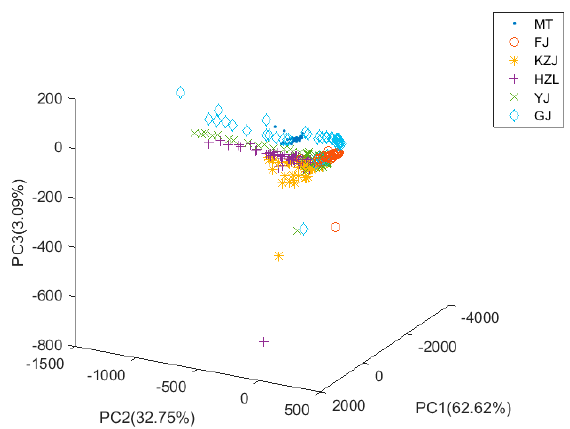
Figure 5. Three-dimensional distribution of data after principal component analysis (PCA). Maotai (MT), Fenjiu (FJ), Kouzijiao (KZJ), Haizhilan (HZL), Yingjiagongjiu (YJ), Gujinggongjiu (GJ).